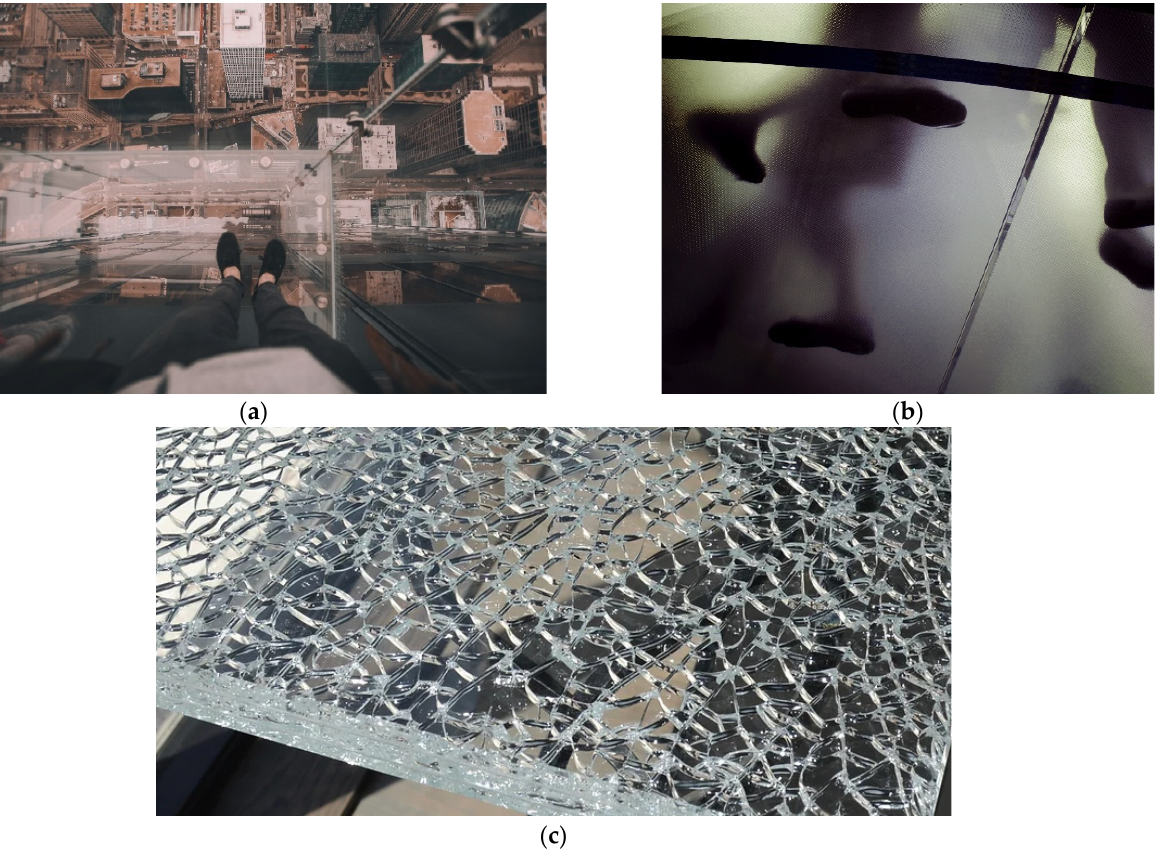
Figure 2. Examples of ( a , b ) glass pedestrian systems and ( c ) LG fracture (figures reproduced with permission from Unsplash).